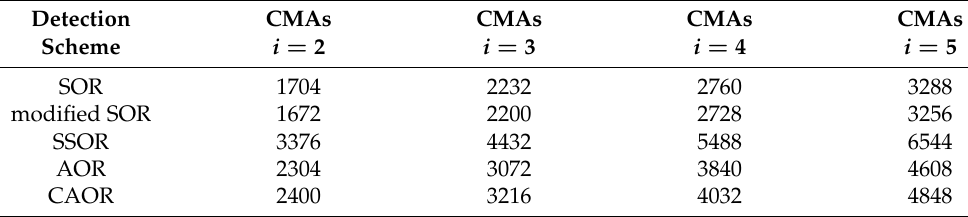
Table 7. The numerical comparison of the complexity for different detection schemes with N T = 16. CMAs